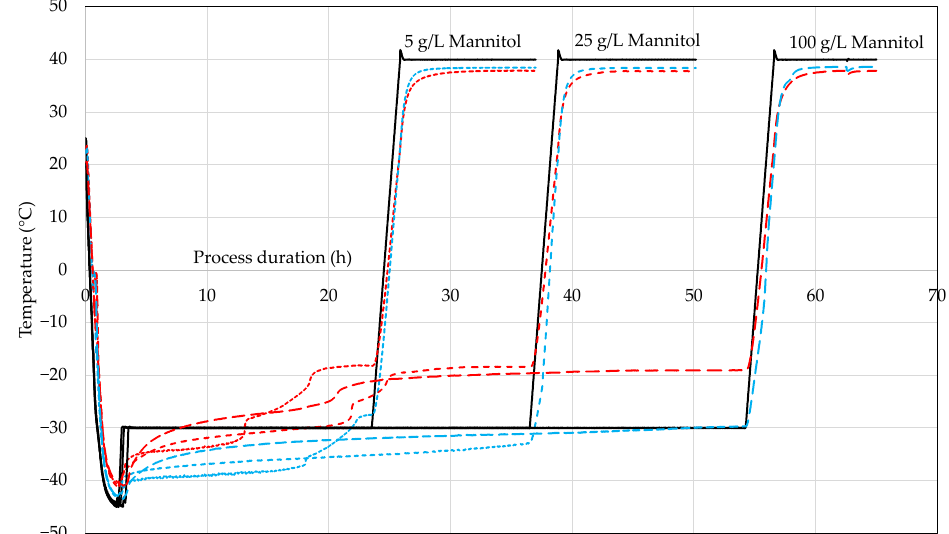
Figure 8. Temperature curves of freeze-drying run with different solute concentrations (black—shelf temperature, blue—center vial, and red—edge vials).